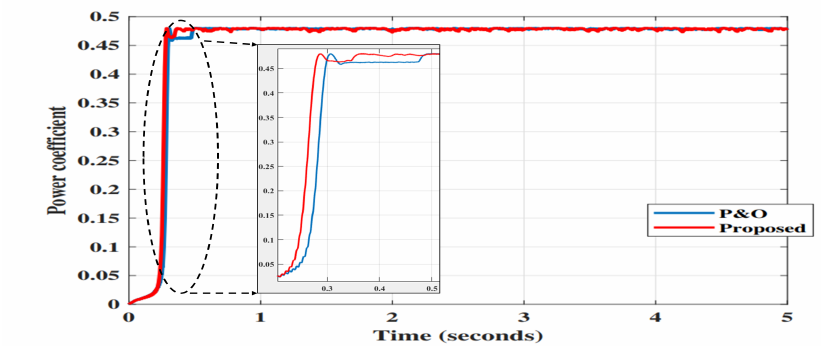
Figure 15. Time and power coefficient for fixed wind speed.